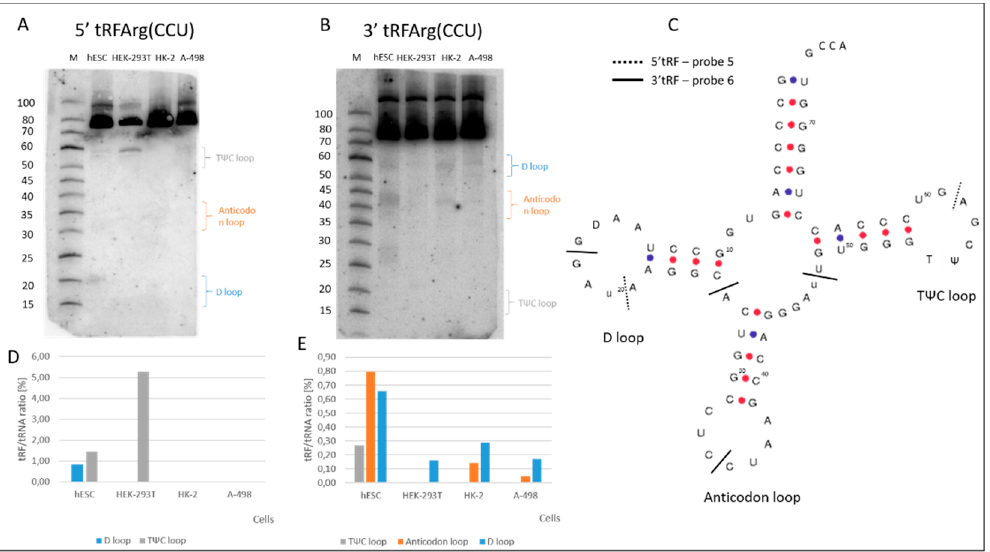
Figure 5. Characterization of the tRNAArg(CCU)-derived fragments. Northern blot ( A ) 5 ′ and ( B ) 3 ′ tRF detection with the application of 32 P labelled probes 5 and 6, respectively (Table S1). ( C ) Secondary structure of human tRNAArg(CCU) with marked 5 ′ (---) and 3 ′ ( ꟷ ) cleavage sites. The locations of some of the modified D (dihydrouridine), T (ribothymidine) and Ψ (pseudouridine) nucleotides are marked in the tRNA structure. The loops in the tRNA structure have been named after these modifications. ( D , E ) tRF occurrence and efficiency of tRNAArg(CCU) cleavage in the analyzed renal cells detected by 5 and 6 probes.